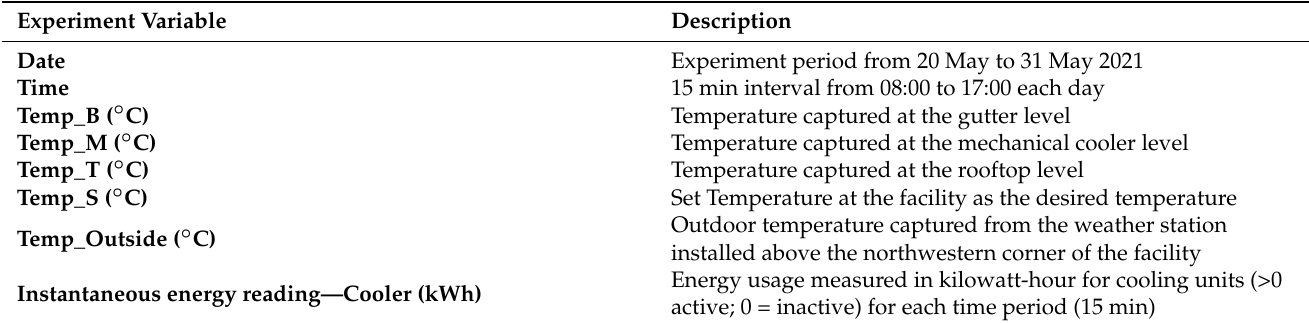
Table 2. Summary of variables for the experiment in the greenhouse